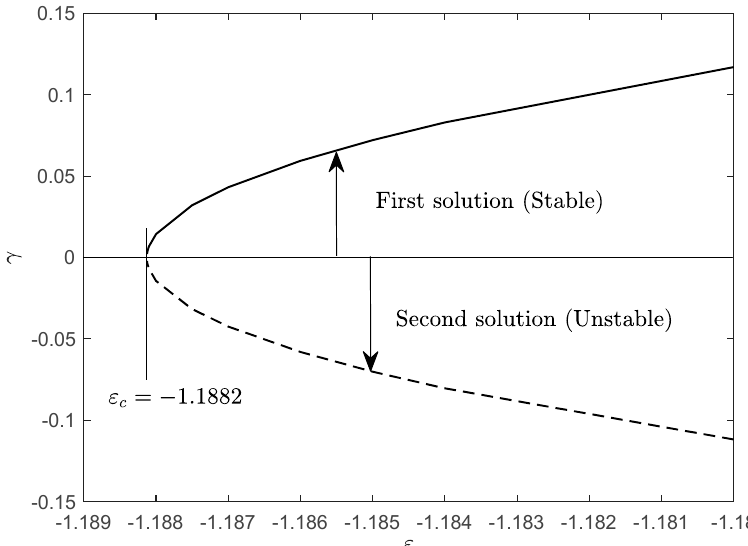
Figure 15. Minimum eigenvalues γ versus ε when ω = 0.01, ϕ = 0.02, S = 2.2, and Pr = 6.2 (water) for SWCNT. Table 6. Minimum eigenvalues 𝛾 for multiple values of 𝜔 and 𝜀 when 𝜑 = 0.02 , 𝑆 = 2.2, and Pr = 6.2 (water) for SWCNT. First Solutions Second Solutions